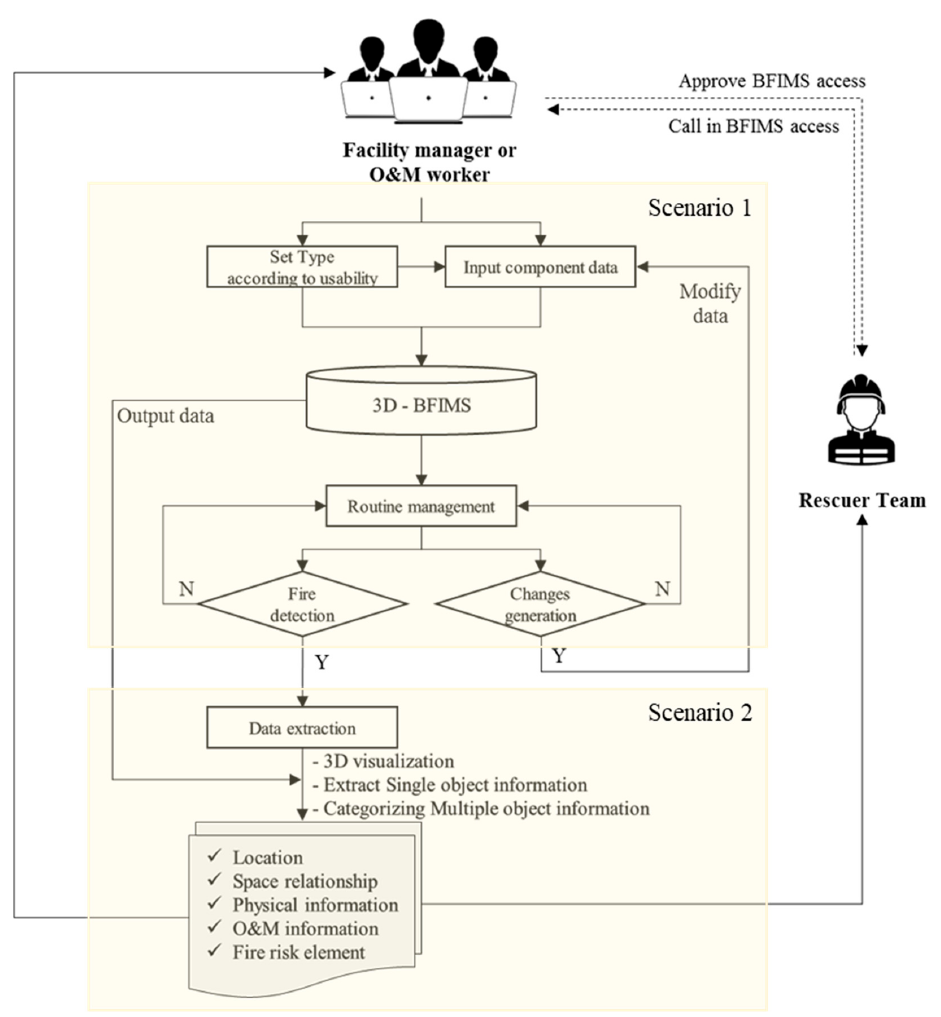
Figure 8. Scenario-based BFIMS application framework.